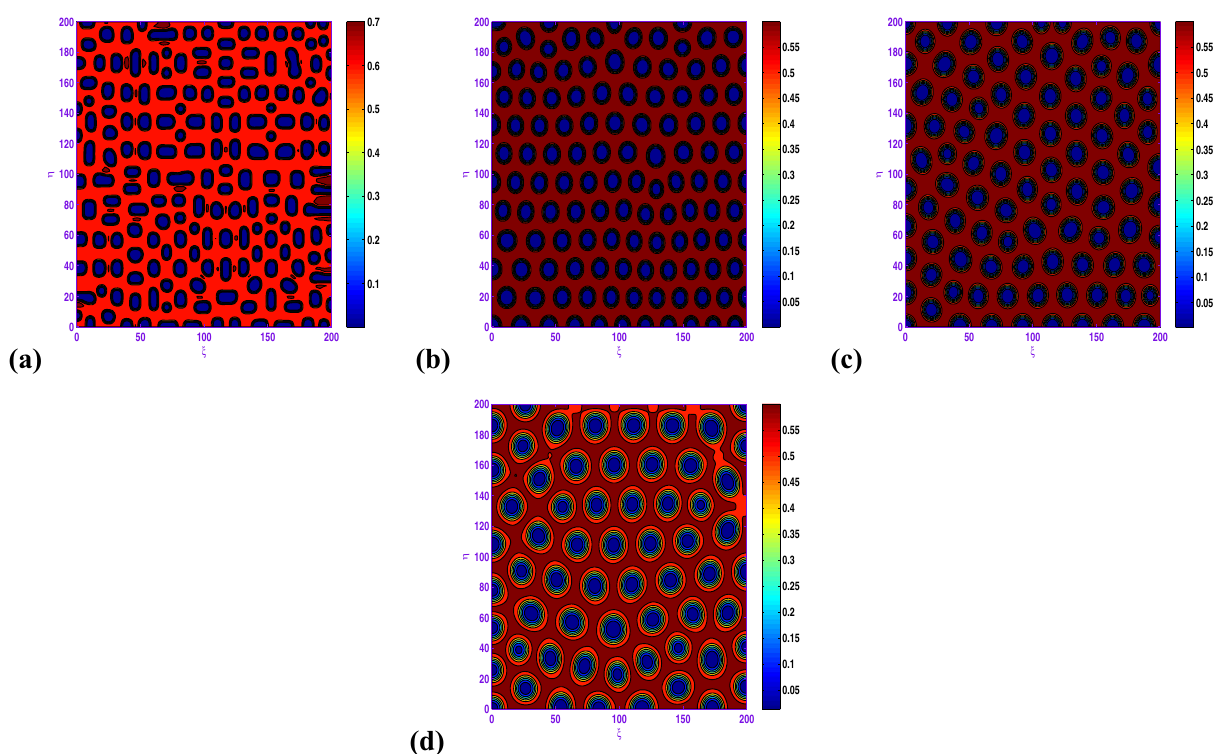
Figure 8. Transition of spatial dynamics of the prey population ( u ) in the model (9) at t = 5000 , for the set: a = 0.5 , b = 0.9 , β = 1.05 , d = 0.3 , l = 0.01 , d d 1 = 0.5 .